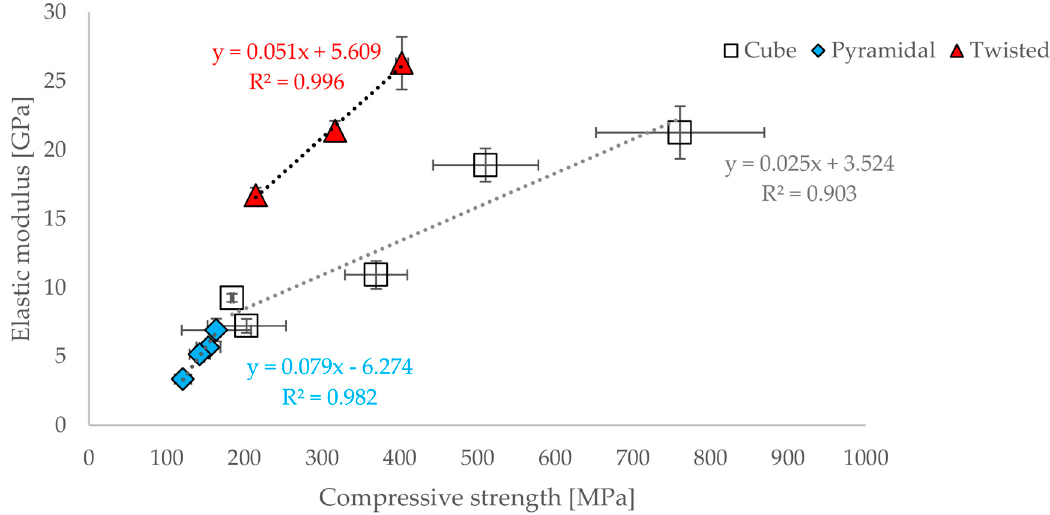
Figure 9. Correlation between compressive strength and elastic modulus in each of the investigated designs. Results are shown as mean values with the corresponding standard deviations. For the linear regressions, the coefficient of determination is shown.